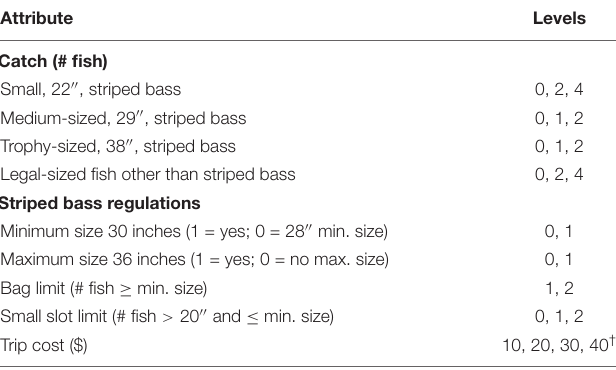
TABLE 1 | Choice experiment attributes and